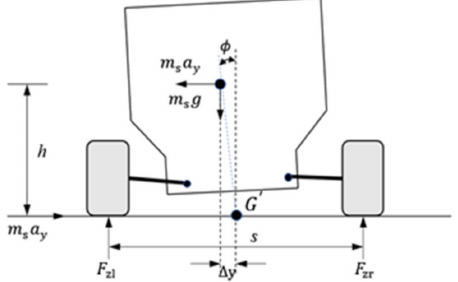
Figure 3. Simplified model of automobile